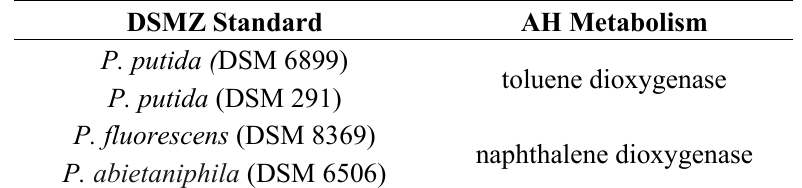
Table 1. Positive standards utilized on the enrichment assay. AH, aromatic